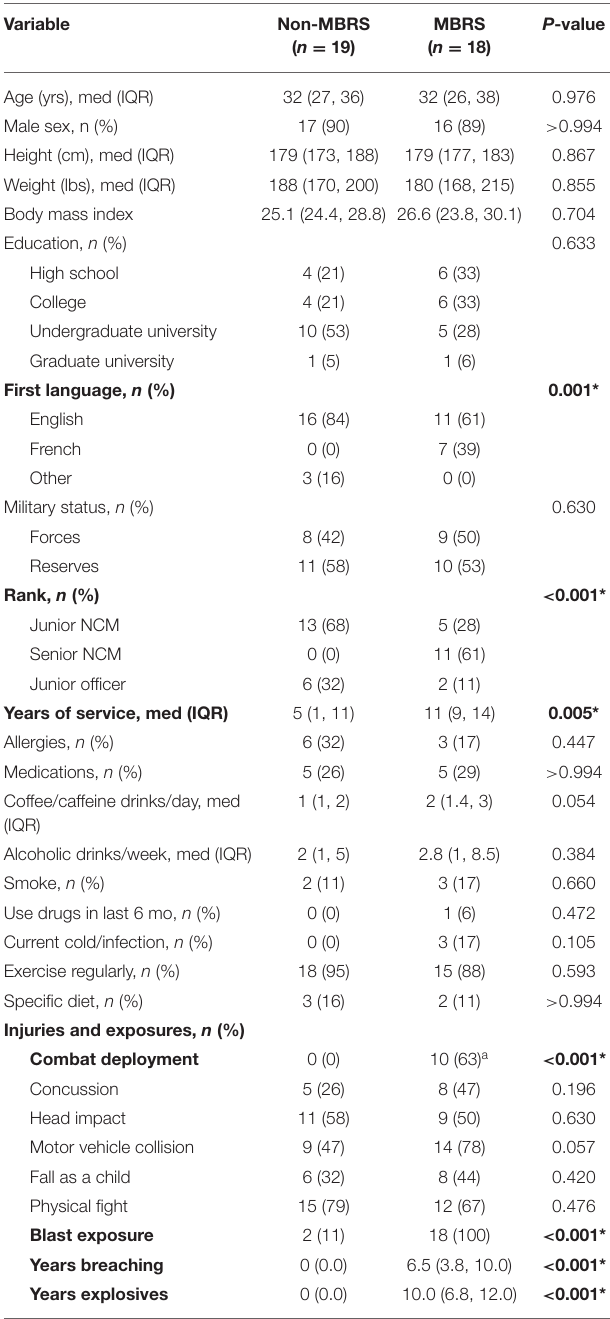
TABLE 1 | Military personnel demographics, service history and